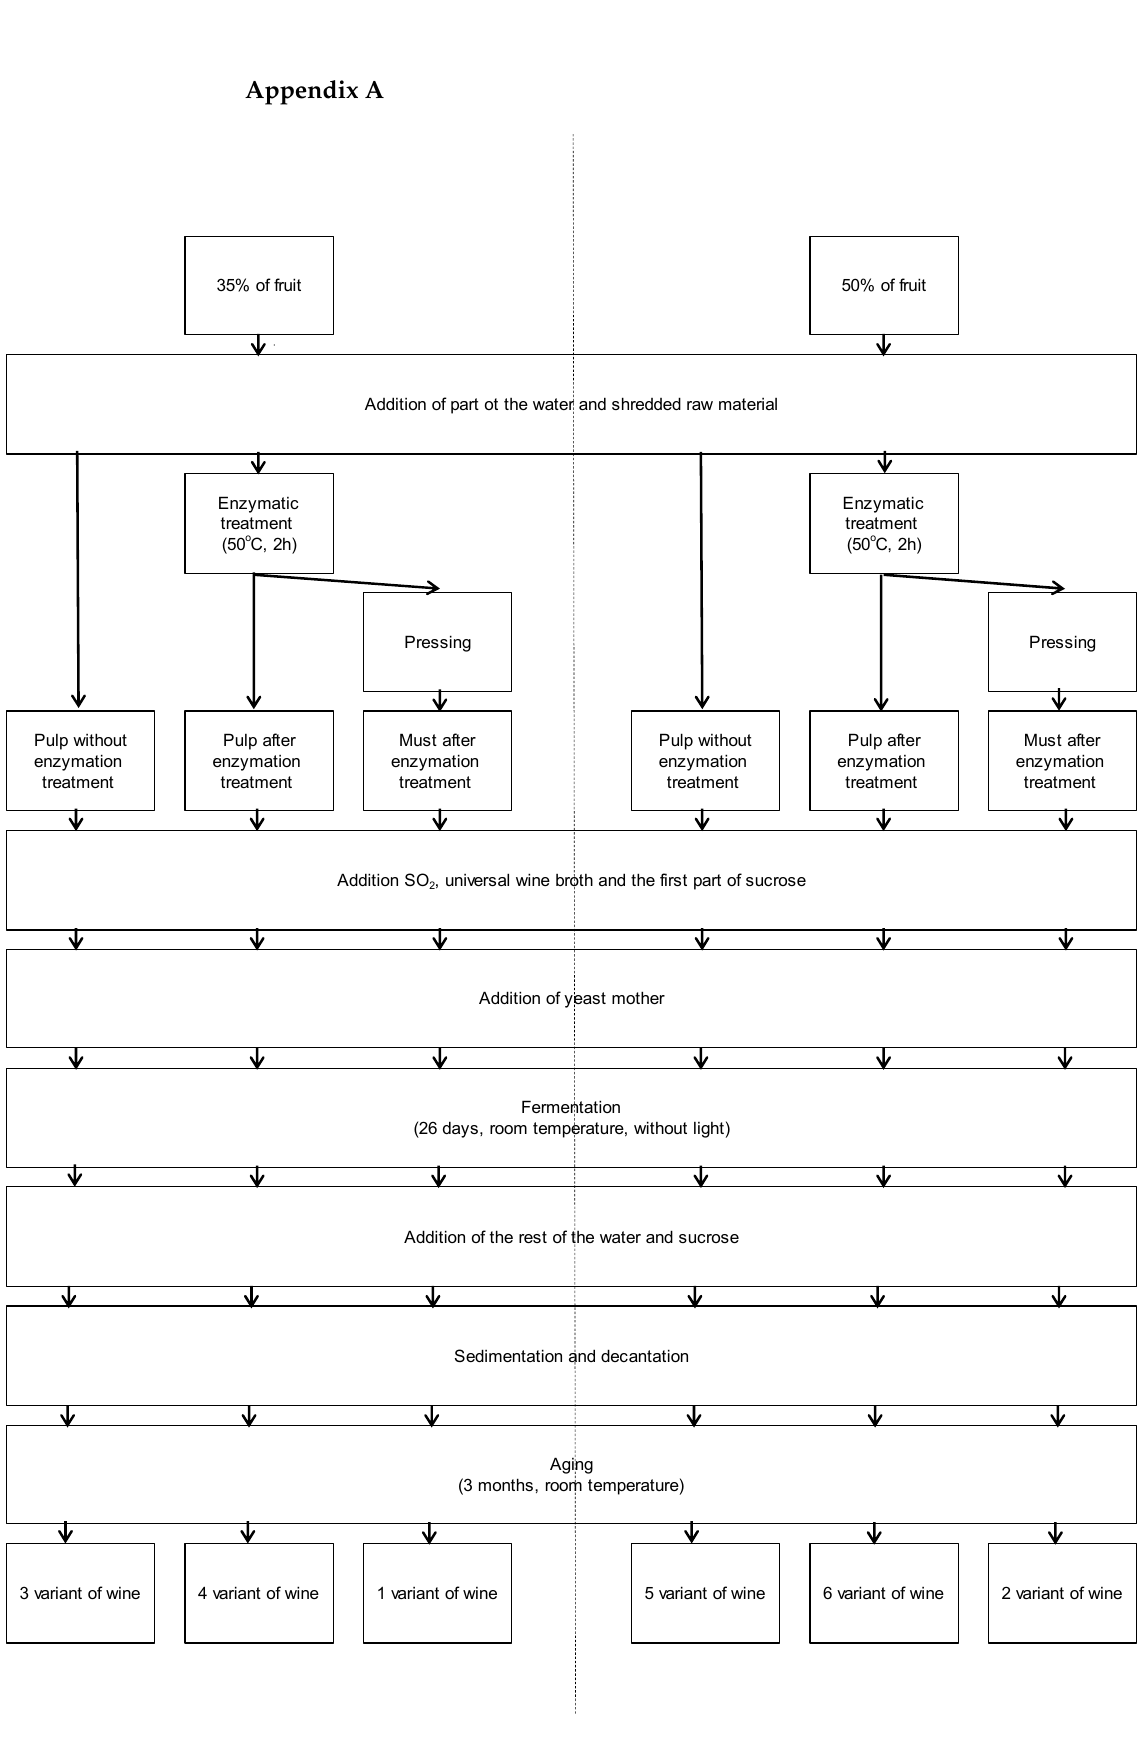
Figure A1. Scheme of process for the preparation of 6 variants of wines from fruits of Rosa rugosa.